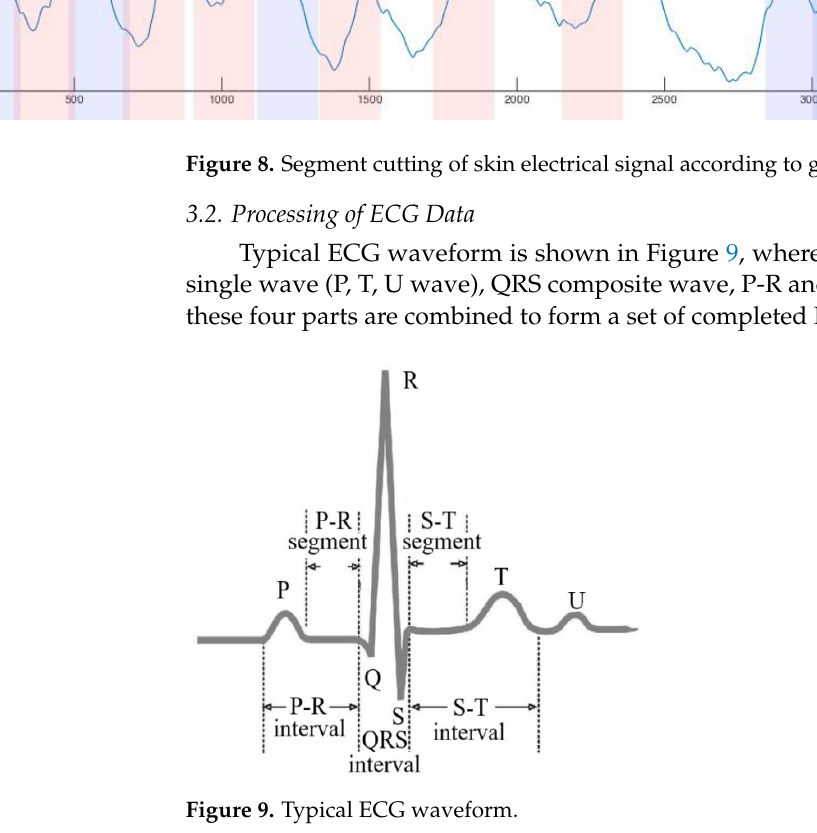
Figure 10. RR interval from ECG signal.